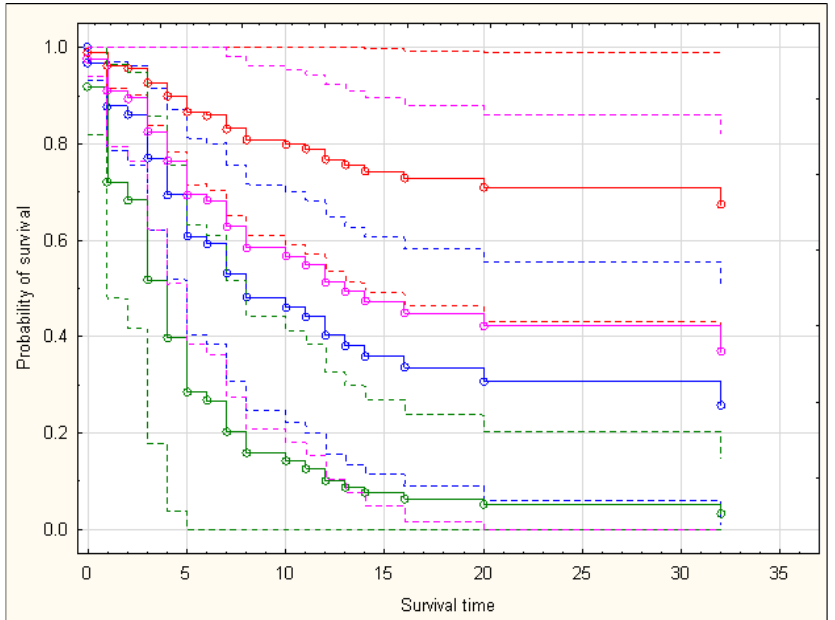
Figure 4. Survival curves for people with a serum hsCRP concentration of 49.02 mg/L (mean value among the sample) and different BMI values and incidence of diabetes. The colors blue, red, green, and pink indicate the following patient parameters, respectively: BMI = 20 and no diabetes, BMI = 20 and diabetes, BMI = 35 and no diabetes, and BMI = 35 and diabetes. Values of other features used by the model (Table 7) were set as equal for all of the four curves in order to visualize the differences in survival curves associated with variable BMI and diabetes comorbidity status. Probability of survival was determined with use of the Breslow estimator.